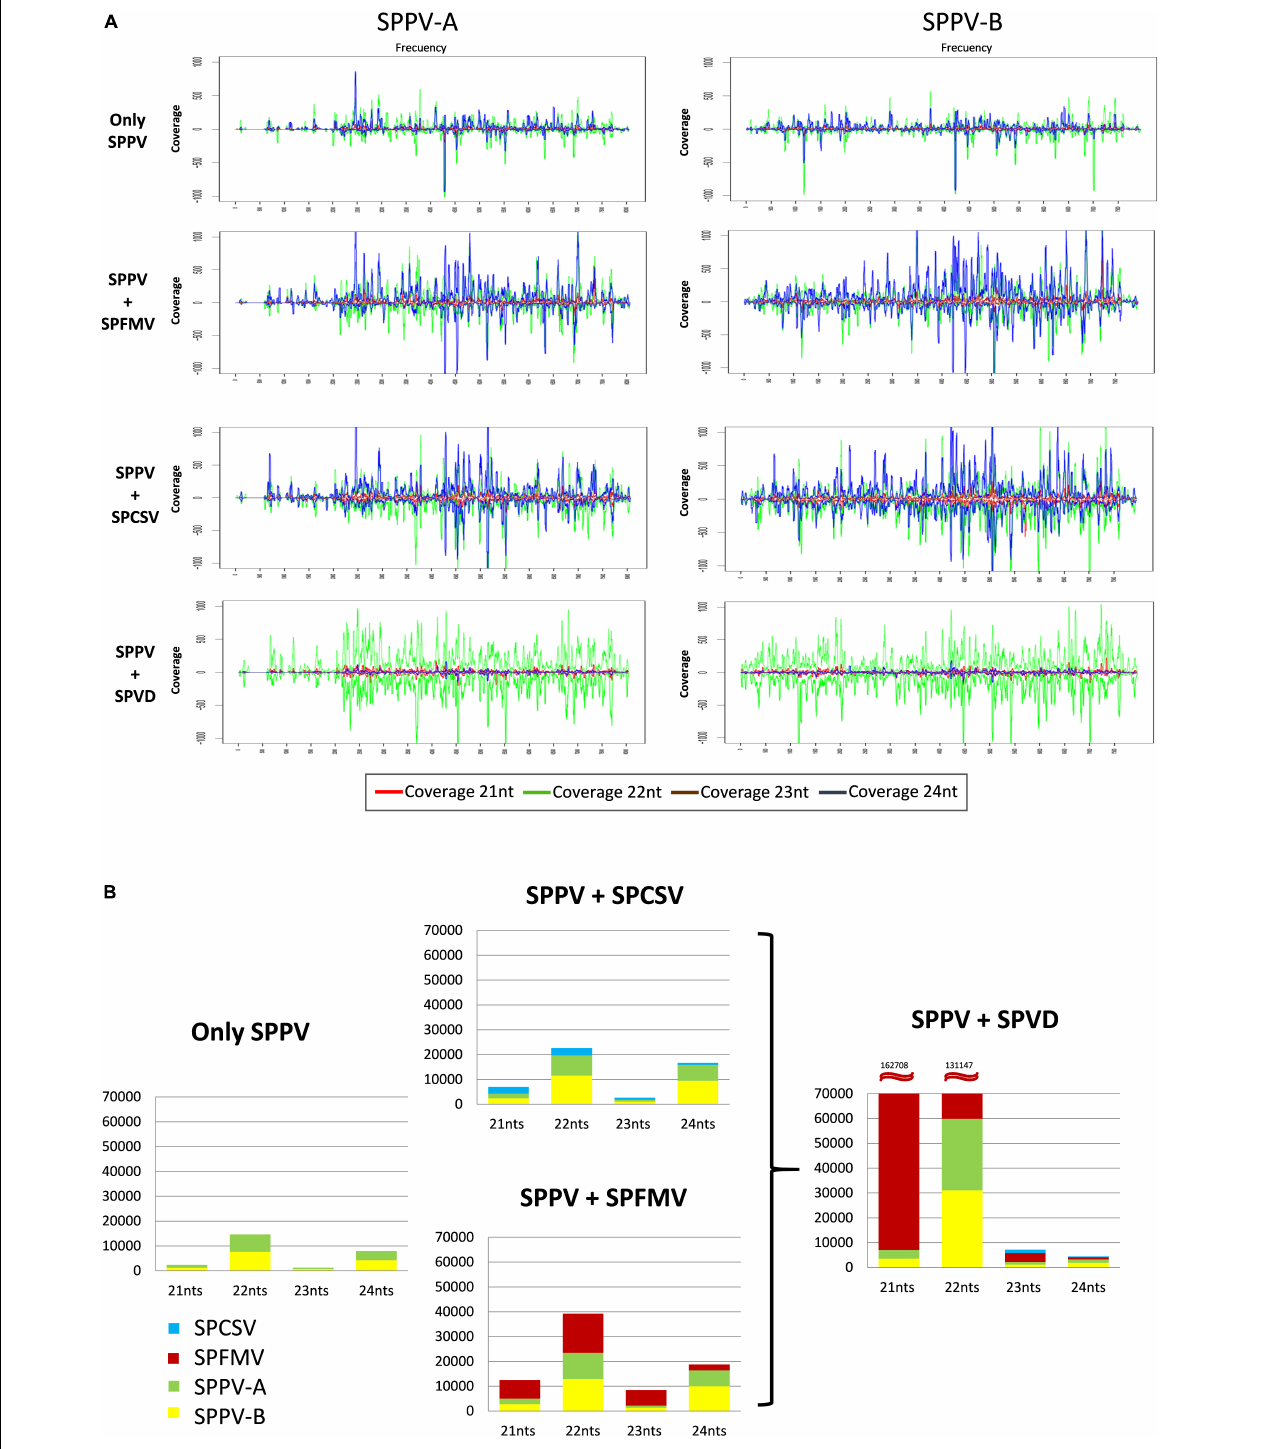
FIGURE 5 | Size and distribution and quantities of siRNAs targeting SPPV in sweet potato plants coinfected with different viruses. (A) Graphics show the normalized distribution (per million siRNA reads sequenced) of siRNA covering the genomes of SPPV-A (left) and -B (right) in plants infected only by SPPV, or coinfected with SPFMV, SPCSV or SPFMV, and SPCSV (SPVD). The horizontal axis indicates the nucleotide position on the virus genome, whereas the vertical axis indicates the coverage of each nt position by siRNA sequences in sense (positive values) and antisense (negative values) orientation. Lines in red, green, brown, and blue represent 21-, 22-, 23-, and 24-nt siRNAs, respectively. (B) Bar graphics showing the normalized (per million siRNA reads sequenced) quantity (vertical axis) and size (horizontal axis) of virus-specific siRNAs in plants coinfected with different viruses. Green, yellow, red, and blue sections in the bars correspond to SPPV-A, SPPV-B, SPFMV, and SPCSV,